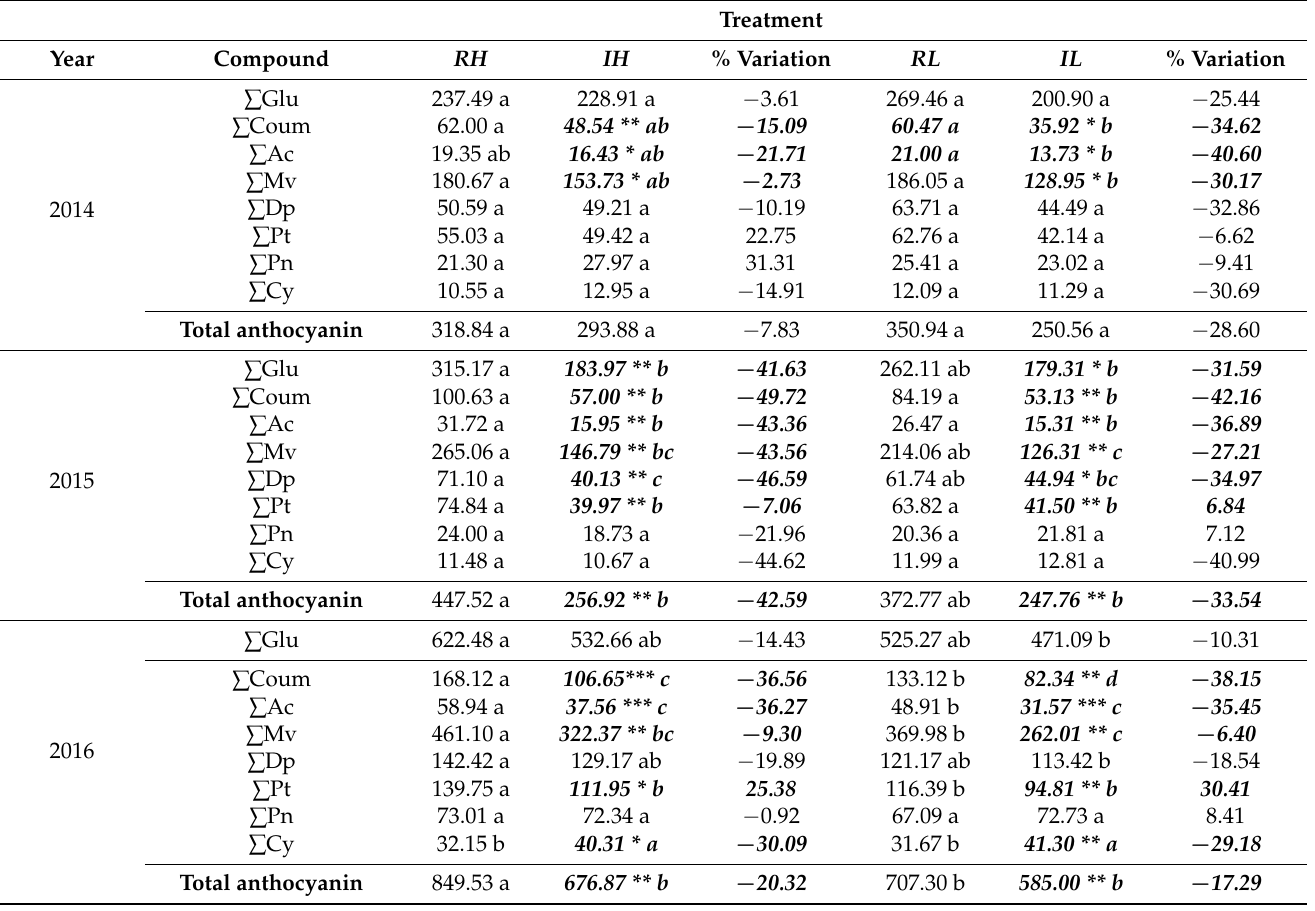
Table 4. Influence of irrigation on concentration of anthocyanins (ANs) compounds (mg. kg − 1 berry fresh weight) under two crop load levels. R : rainfed; I : non-limiting irrigation; H : high crop load; L : low crop